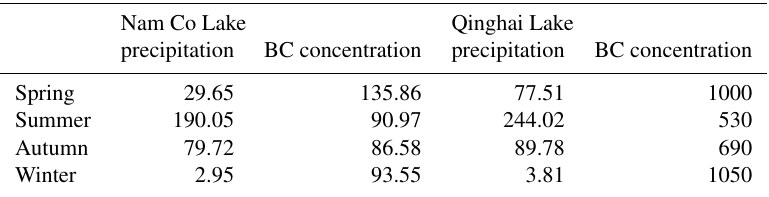
Table 2. Precipitation (mm) and BC concentration (ngm − 3 ) values used for the BC deposition calculations for Nam Co Lake and Qinghai Lake. Nam Co Lake Qinghai Lake precipitation BC concentration precipitation BC concentration